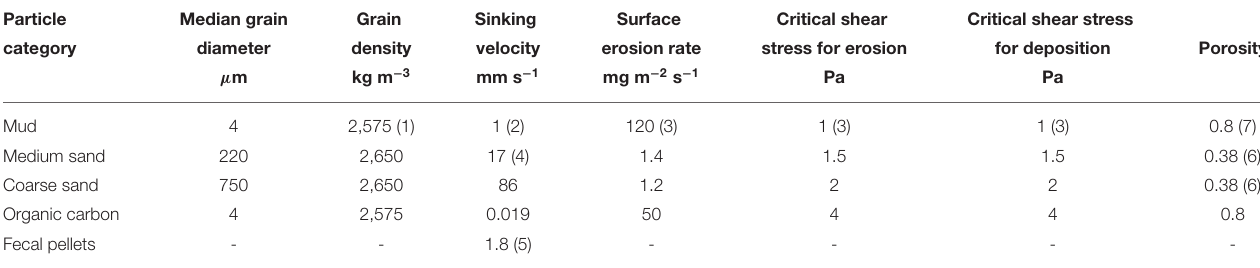
TABLE 1 | Parameters associated with each modeled class of organic and non-organic particles. Particle Median grain Grain Sinking Surface Critical shear Critical shear stress category diameter density velocity erosion rate stress for erosion for